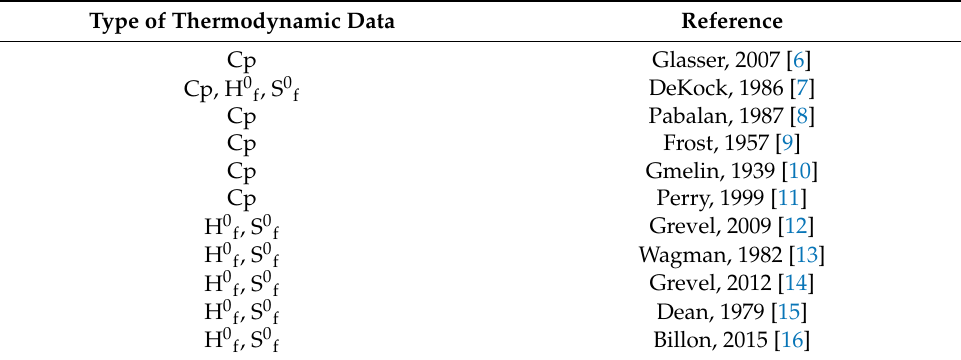
Table 1. Gathered thermodynamic data for MgSO 4 · 1H 2